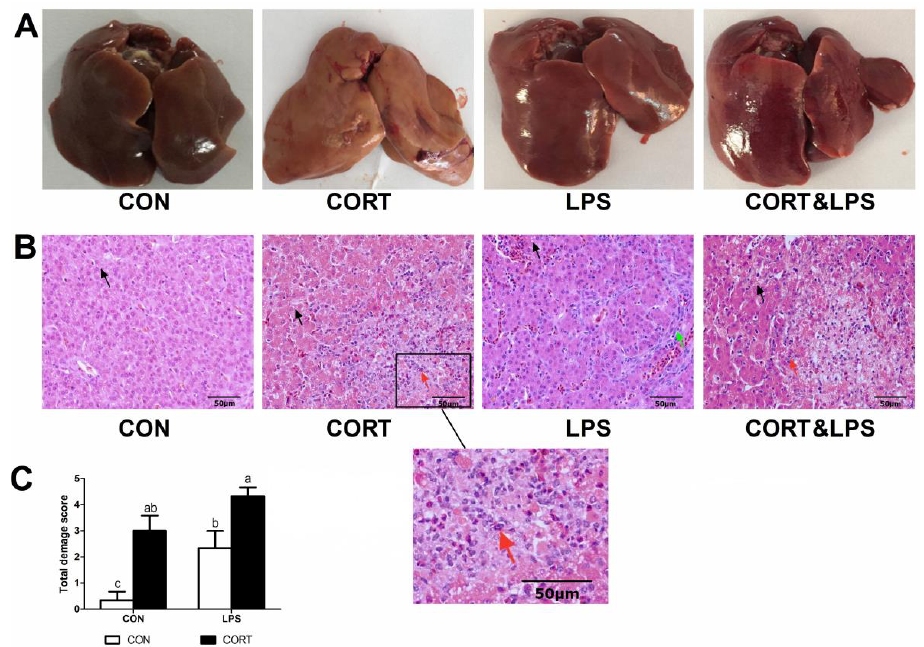
Figure 2. Phenotypic characterization of liver damages. ( A ) Phenotypic presentation of the liver. ( B ) Hepatic histological sections stained with hematoxylin and eosin (HE). ( C ) Total damage score of hepatic histological sections. Representative histological sections of the liver were observed with x40 magnification. Black, red, and green arrows indicate vacuolar degeneration, hepatocytes necrosis, and interstitial substance proliferation, respectively. CON, control group; CORT, corticosterone-treated group; LPS, lipopolysaccharide -treated group; CORT&LPS, corticosterone- and LPS-treated group. a-c Means with different small letter superscripts are significantly different ( p < 0.05).